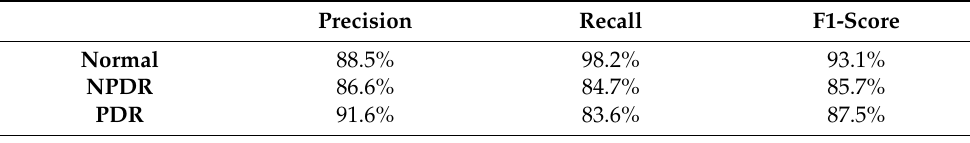
Table 6. Performance metrics of Inception-ResNetV2.